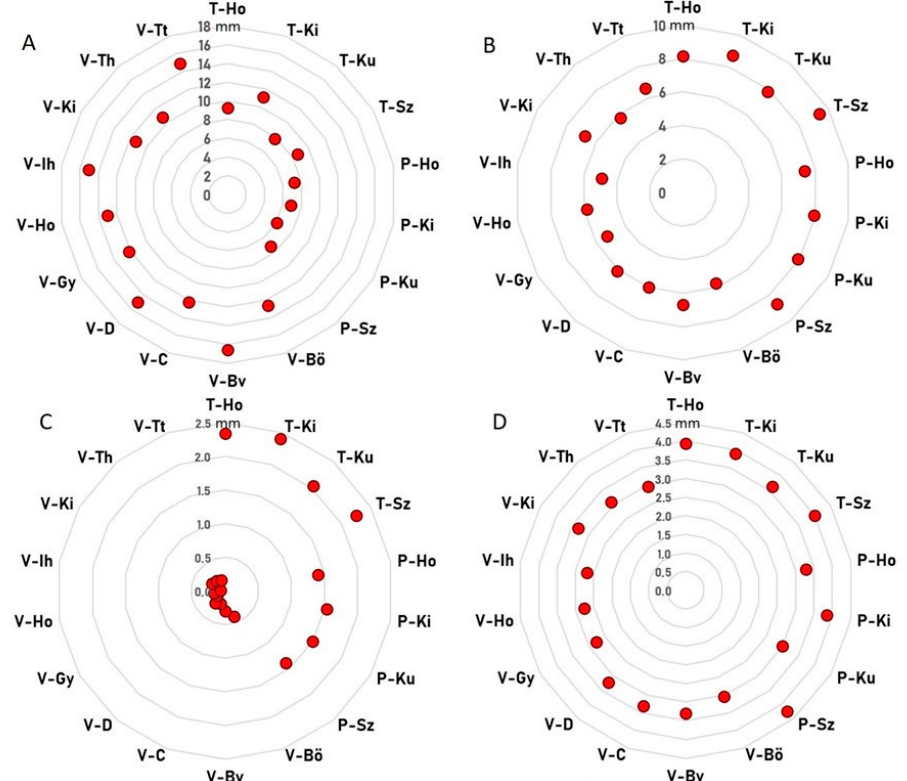
Figure 5. Radar chart with polar grid type options of some morphologycal marcs of investigated Festuca taxa ( A : the length of inflorescence, B : length of the 4th spikelet from the top of branch, C : the length of the 2nd flower’s awn, D : length of upper glume, V: F. vaginata , P: F. pseudovaginata , H: F. tomanii